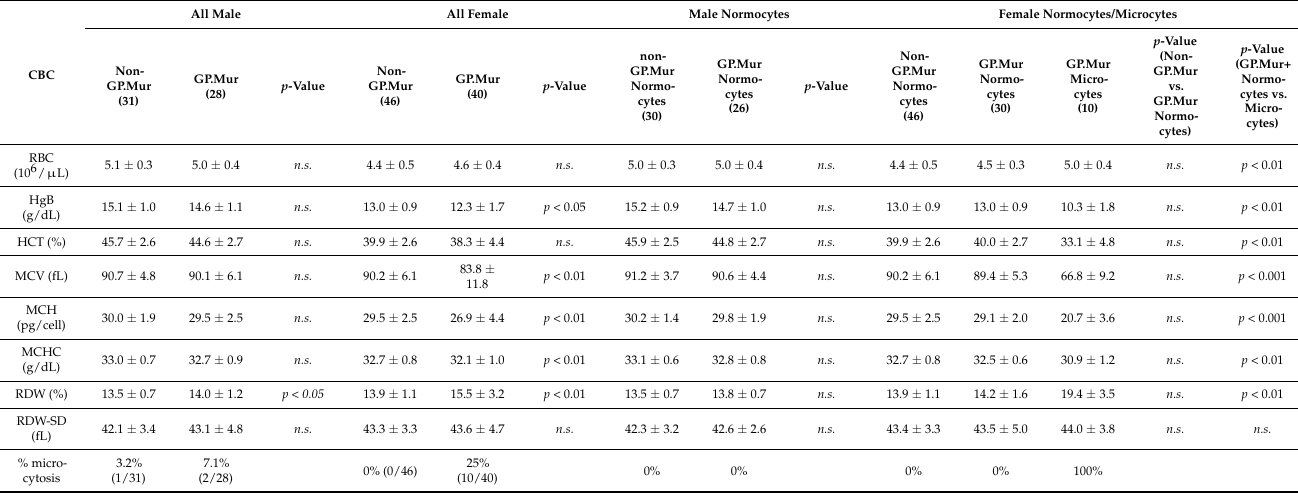
Table 1. Complete blood count (CBC) for GP.Mur+ and non-GP.Mur adult subjects in this study. The left sections included data from all subjects; the right sections compare data from subjects with and without microcytosis/hypochromia. Statistical differences between groups were estimated by two-sample t -test; p < 0.05 was deemed statistically significant; n.s ., not significant. The number of subjects per group is indicated inside parentheses. Data are shown in mean ±